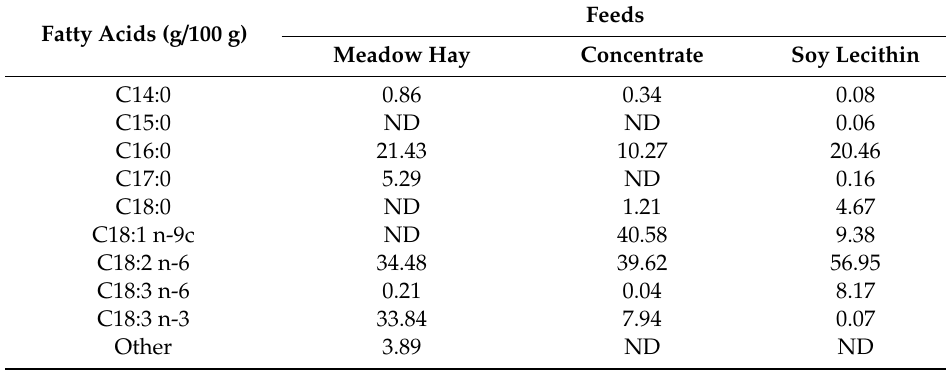
Table 1. Fatty acids composition in all used feeds and soy lecithin